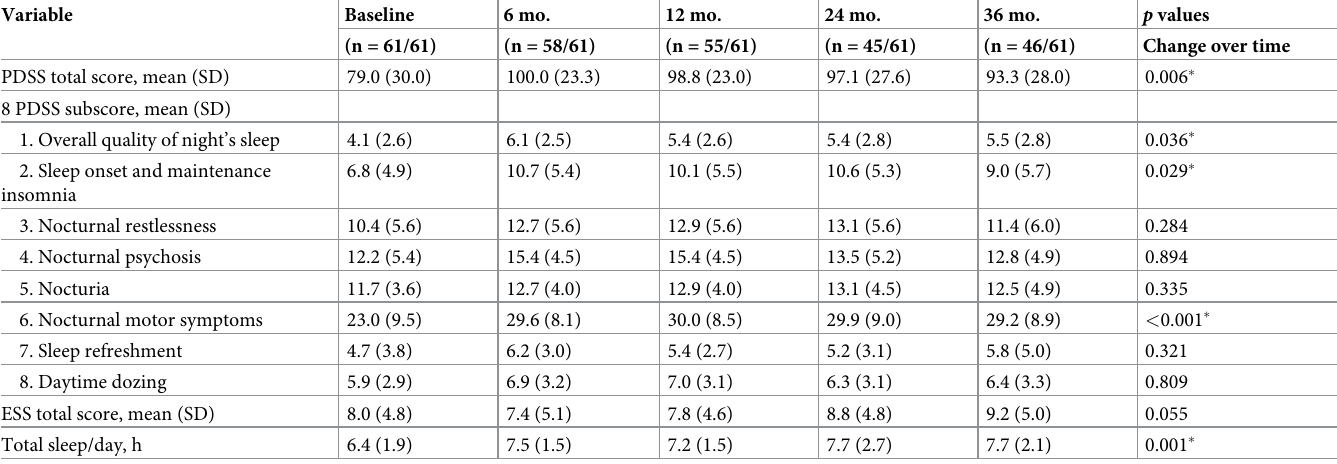
Table 3. Sleep parameters as PDSS and ESS scores and sleep hour per day over time in PD patients with STN DBS.